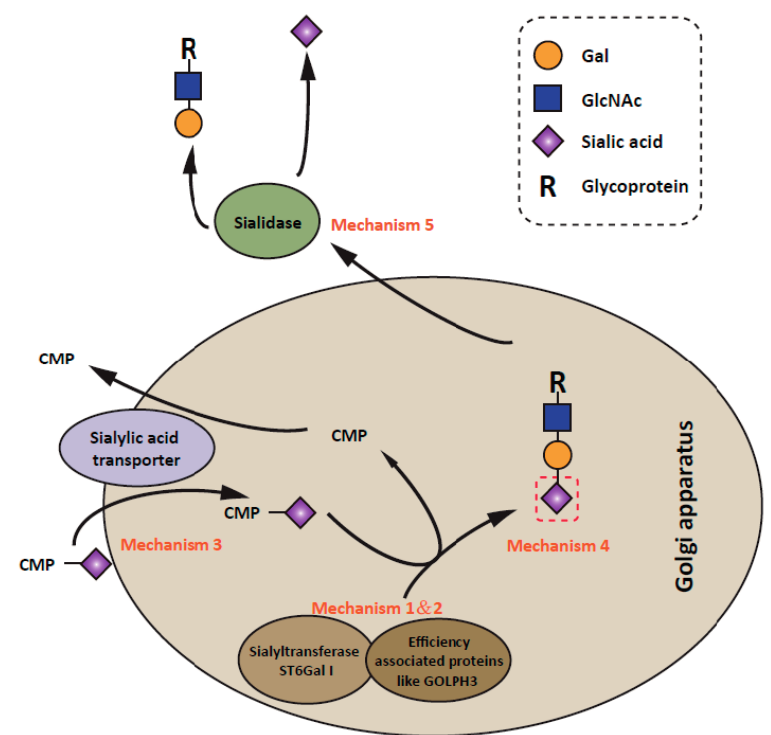
Figure 2. Schematic representation of the regulation of α 2,6 sialylation expression. The expression level of surface α 2,6 sialylation is increased in tumors by several